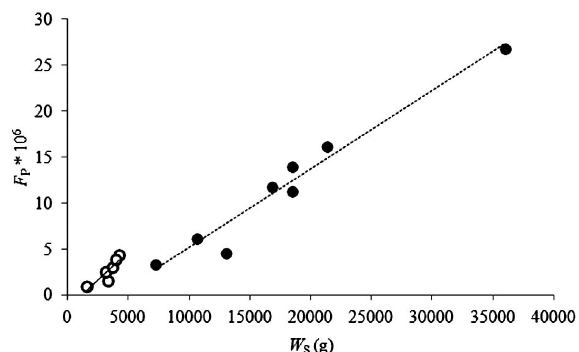
f ig . 8. – Curve of F -weight relationship. White circles correspond P to reared females, and black circles correspond to Cádiz wild